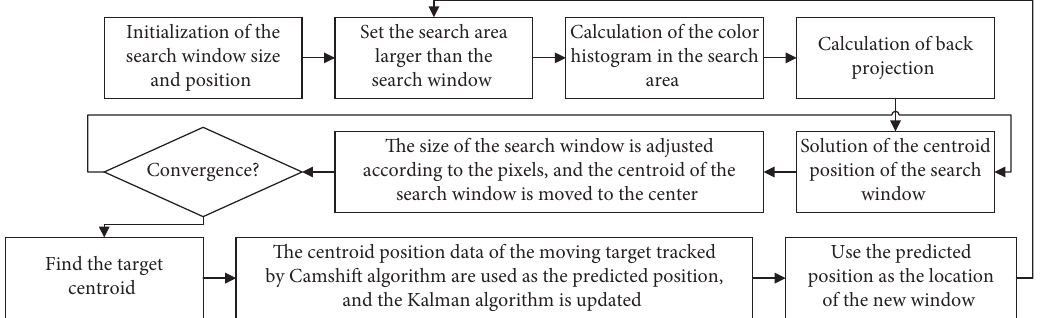
Figure 2: Modified Camshift